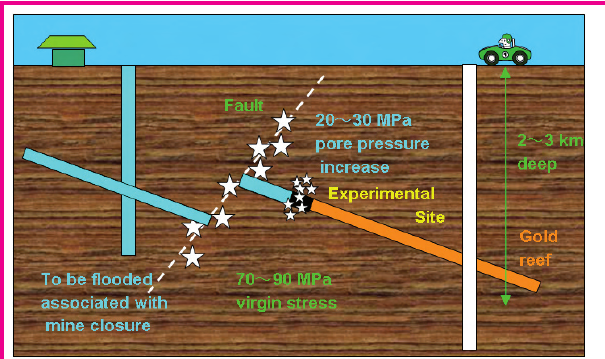
Figure 7. A schematic illustration of monitoring the seismicity (stars) associated with flooding from the adjacent working